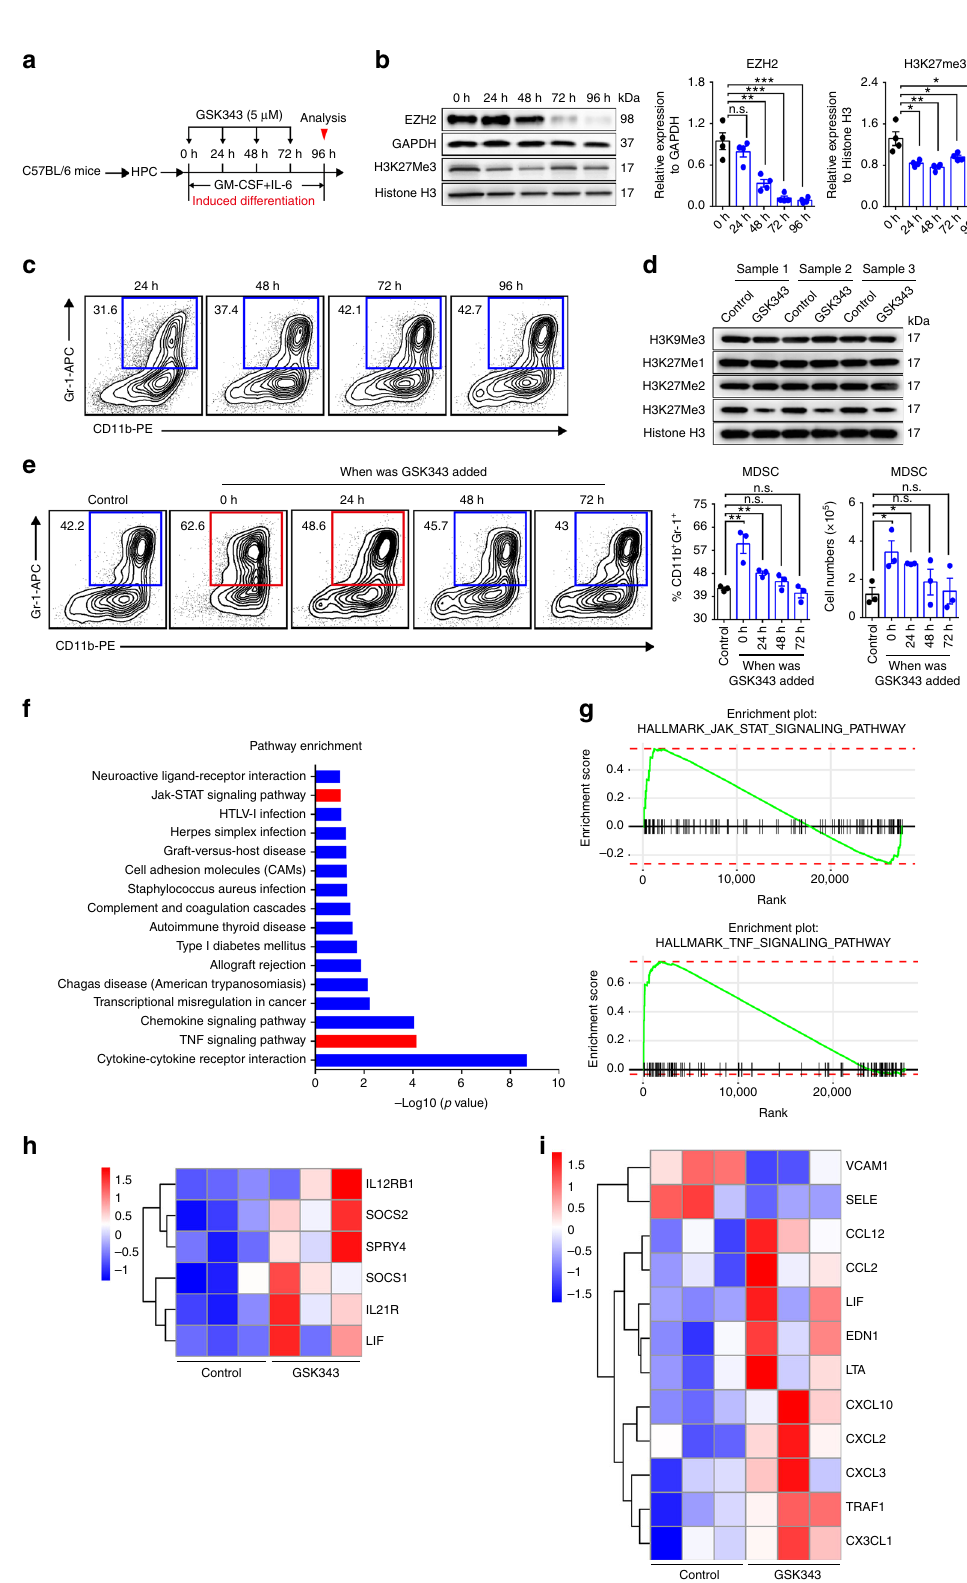
Fig. 9d), or the further differentiation of MDSCs (Supplementary Fig. 9e). To uncover potential molecular mechanisms underlying the GSK343-mediated facilitation of MDSC induction, we performed RNA sequencing (RNA-seq) analysis of in vitro-induced HPCs